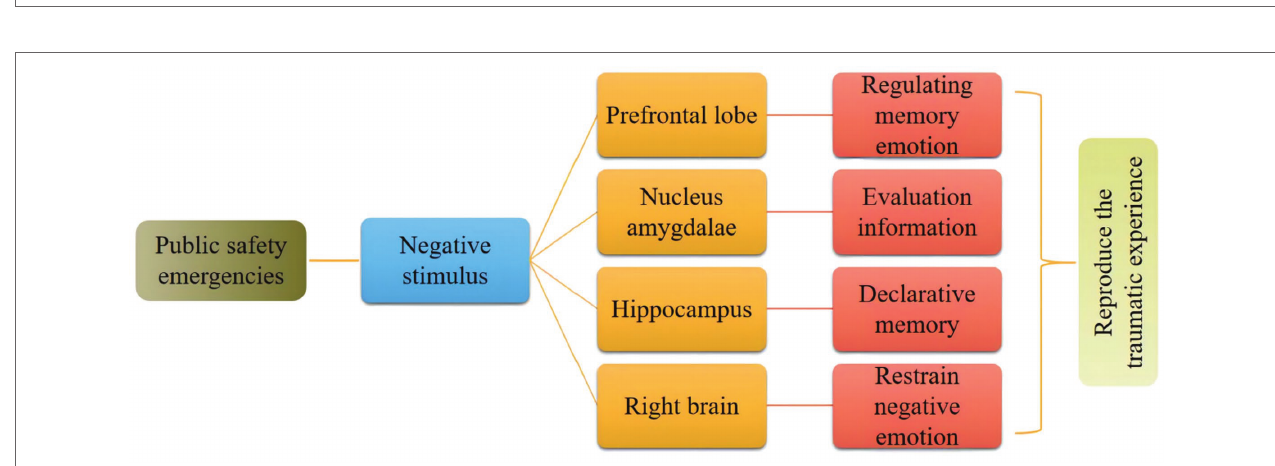
FIGURE 2 | Mechanism of public safety emergencies on group psychological stress response.